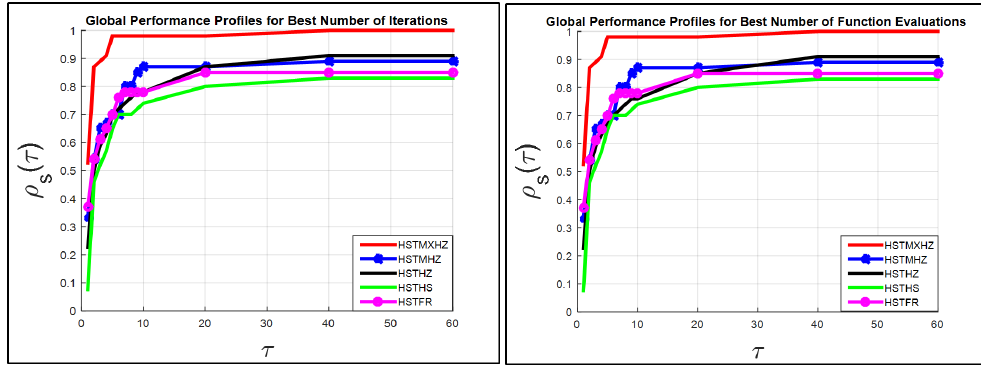
Figure 2. Best number of iterations and function evaluations performance